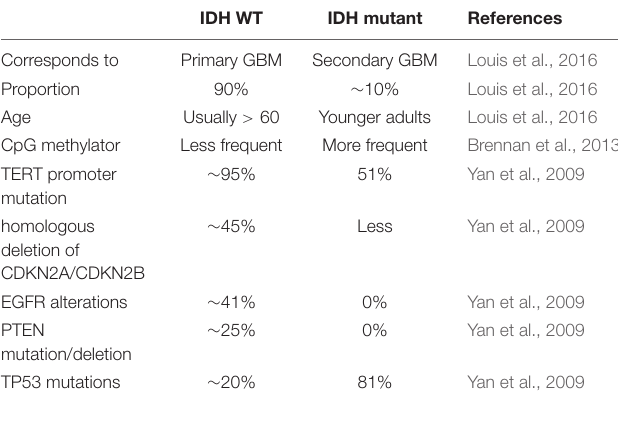
TABLE 2 | The characteristics of IDH WT subtype and IDH mutant